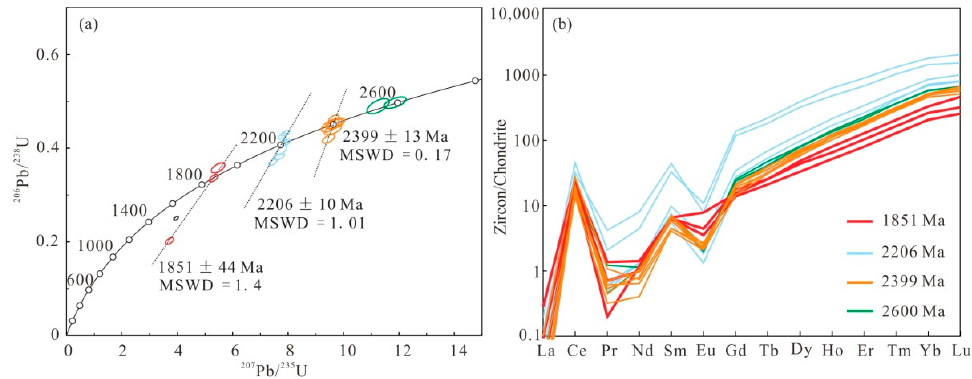
Figure 4. Ziron concordia diagram ( a ) and REE patterns [46] ( b ) of the Paleoproterozoic Gaositai hornblendite.